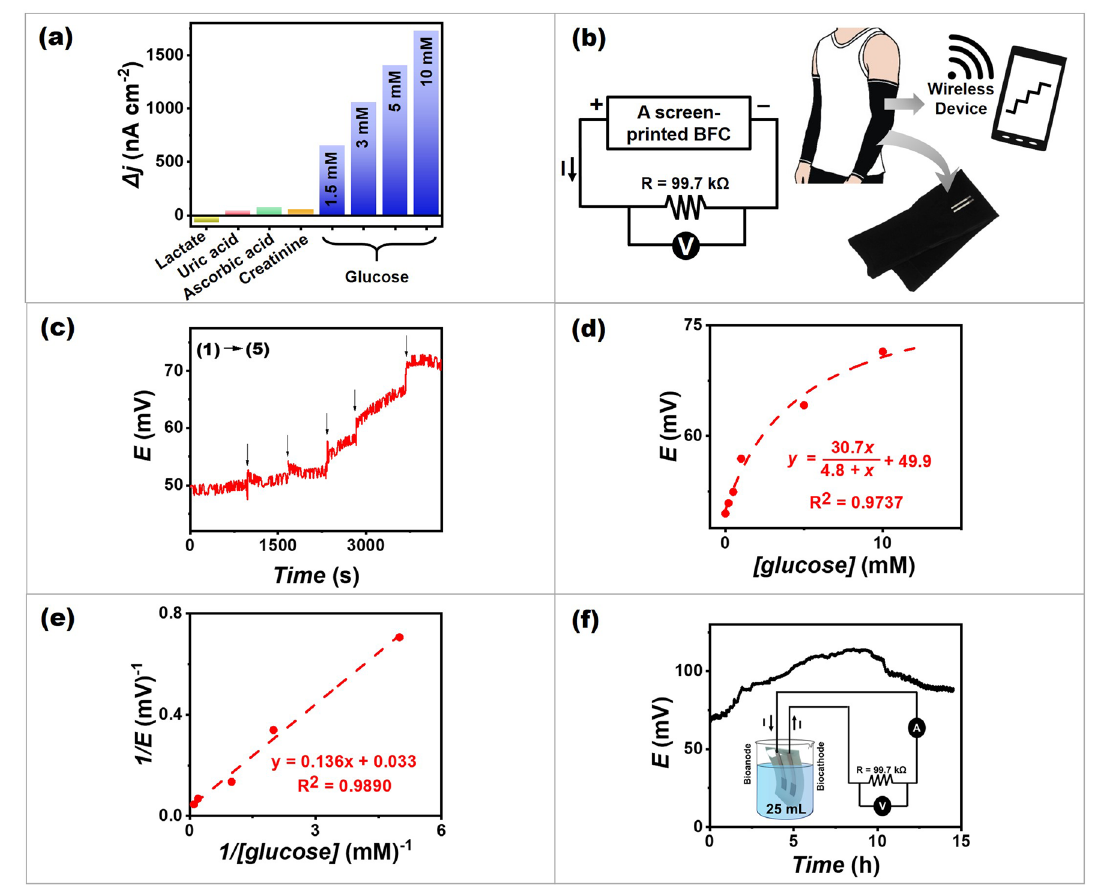
Fig. 5 Applications of a flexible single-enzyme-based energy-harvesting device and self-powered biosensors. a The self-generated current response obtained from a screen-printed glucose BFC, with no applied potential upon interferences adding (14 mM lactate, 59 μM uric acid, 10 μM ascorbic acid, and 84 μM creatinine). The current was observed at a constant load between electrodes of 99.7 kΩ. b Schematic illustra- tion of a screen-printed glucose BFC on a stretchable textile of the arm sleeve together with a circuit of the system. c The self-generated voltage output obtained from a screen-printed glucose BFC and a wireless voltmeter, with no applied potential upon increasing the glucose concentra- tions (0, 0.2, 0.5, 1, 5 and 10 mM) in artificial sweat. The voltage was observed at a constant load between electrodes of 99.7 kΩ. d The cor- responding calibration plot of self-generated voltage output and glucose concentrations. e The double reciprocal plot of the calibration curve (background subtraction). f The operational stability of a screen-printed glucose BFC in the presence of 5 mM glucose in artificial sweat over 15 h with a schematic illustration of the testing cell and a circuitry